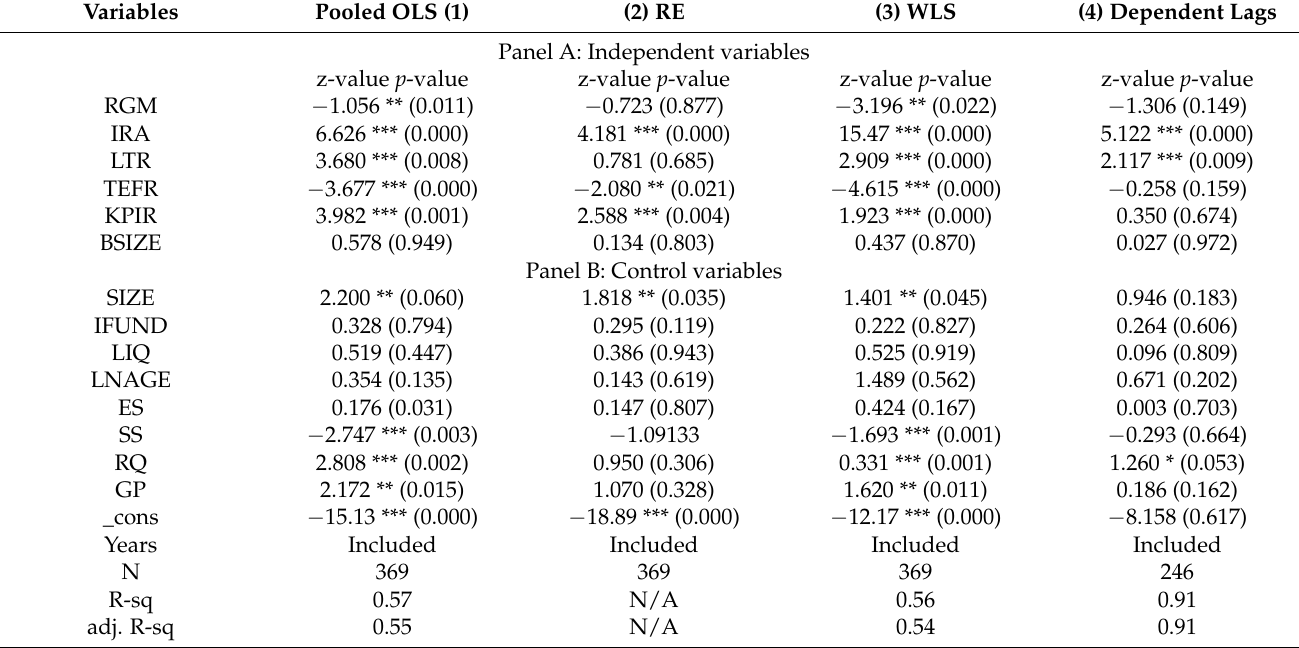
Table 6. Influence of HEI specific characteristics on IR content elements and core activities